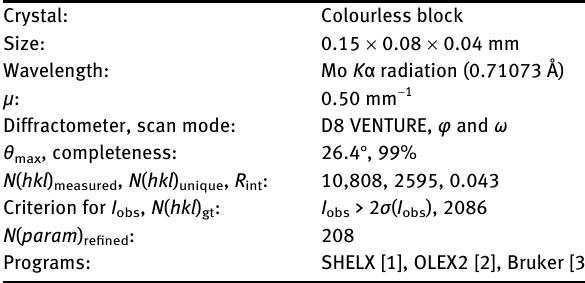
Table  : Data collection and handling. Crystal: